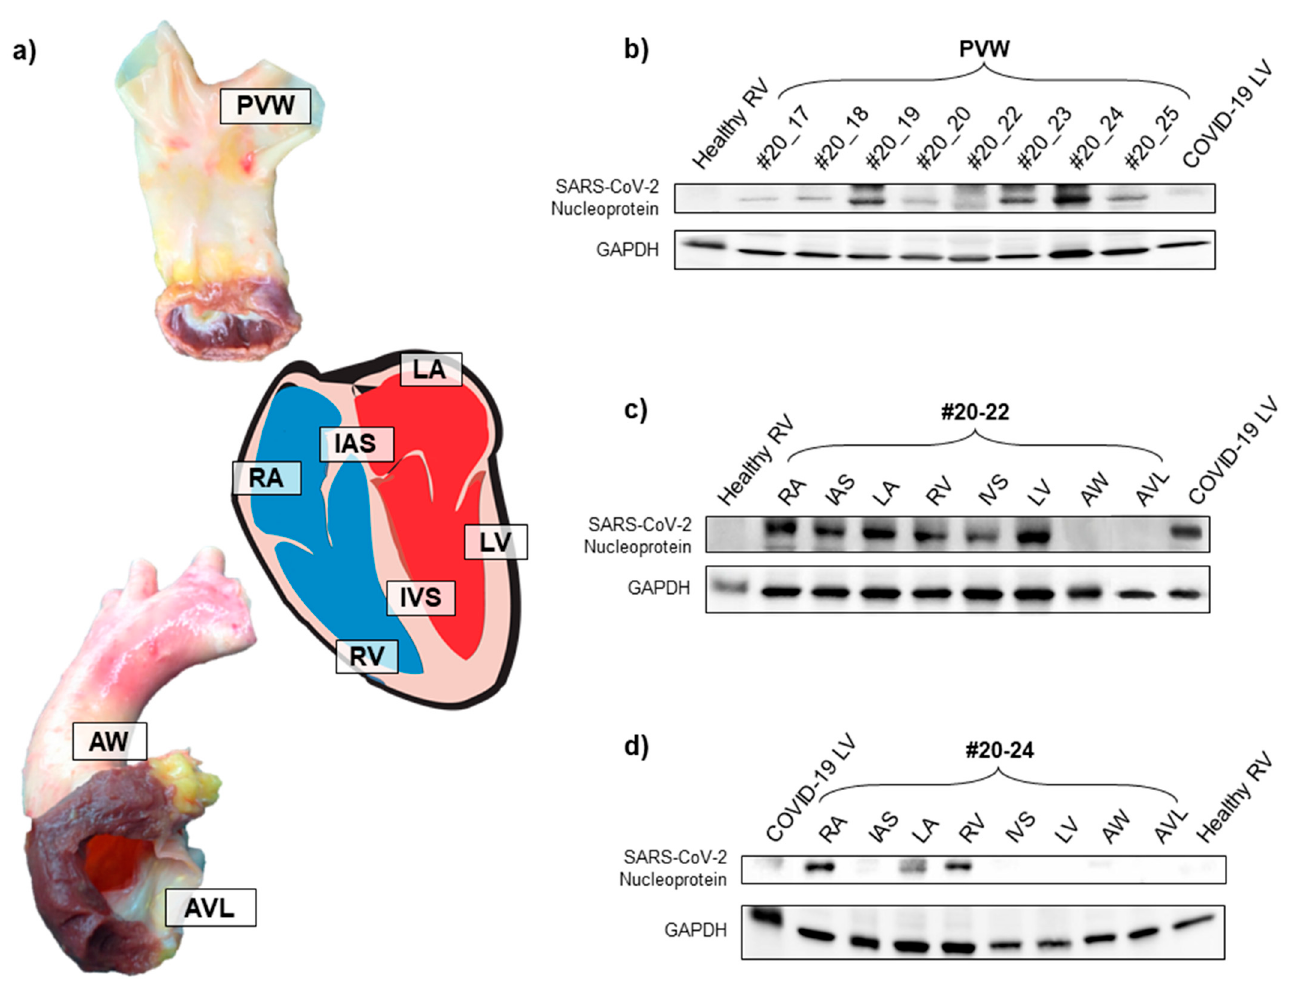
Figure 1. SARS-CoV-2 nucleoprotein was present in several tissues of COVID-19-negative donors. ( a ) Representative images of donor tissue specimens analyzed by Western blot. Labels in the images show the location of tissue sampling in each organ/tissue. ( b ) Western blot analysis for SARS-CoV-2 nucleoprotein on total protein extracts from tissues of 8 different deceased donor PVW specimens, RV specimens from healthy donors (collected prior to COVID-19 pandemic), and LV specimen from COVID-19-positive deceased patient. GAPDH was used as a loading control protein. ( c , d ) Western blot analysis for SARS-CoV-2 nucleoprotein on total protein extracts from different cardiac and valve tissues of 2 deceased donors (#20-22 and #20-24) positive for SARS-CoV-2 serological assay. RV specimen from a healthy donor (collected prior to COVID-19 pandemic) and LV specimen from a COVID-19-positive deceased patient were used as controls. GAPDH was used as the loading control protein. PVW: pulmonary vein wall; RA: right atrium; IAS: interatrial septum; LA: left atrium; RV: right ventricle; IVS: interventricular septum; LV: left ventricle; AW: aortic wall; AVL: aortic valve leaflet.